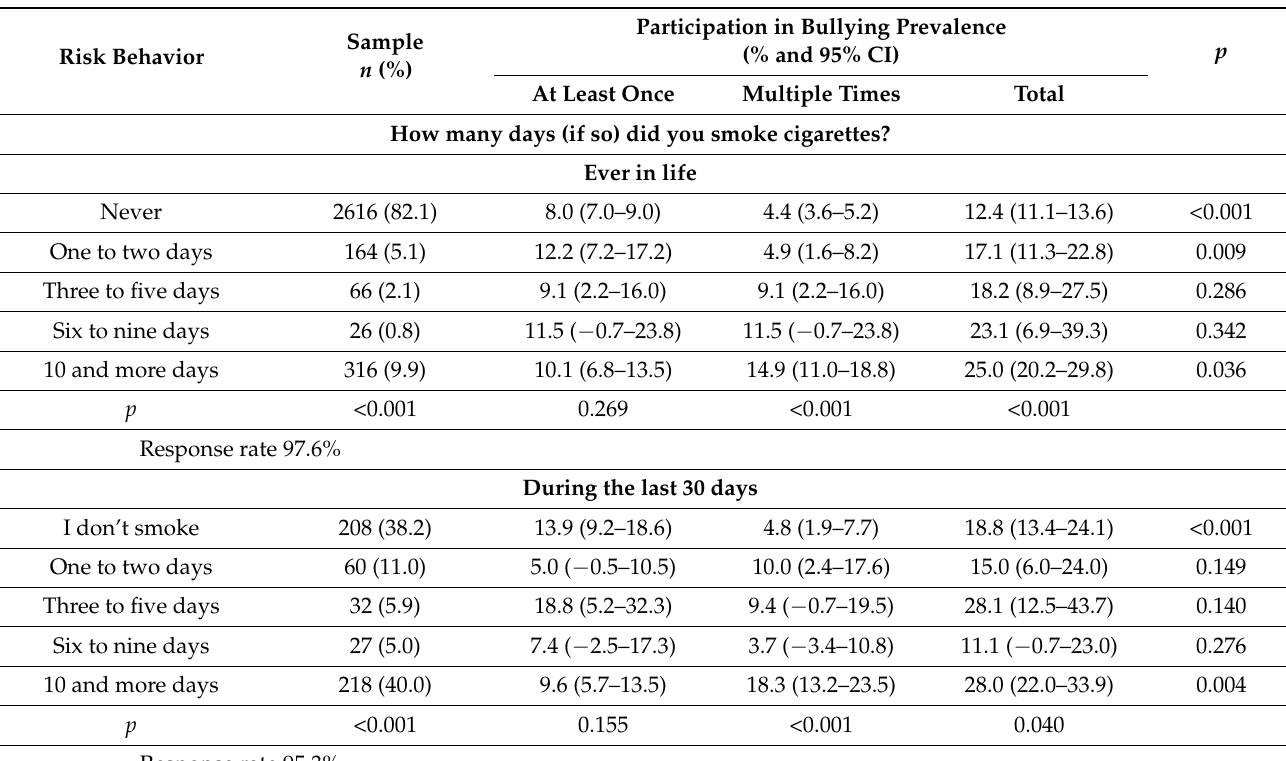
Table 2. Prevalence of bullying among school-age children and risk behavior, Serbia,